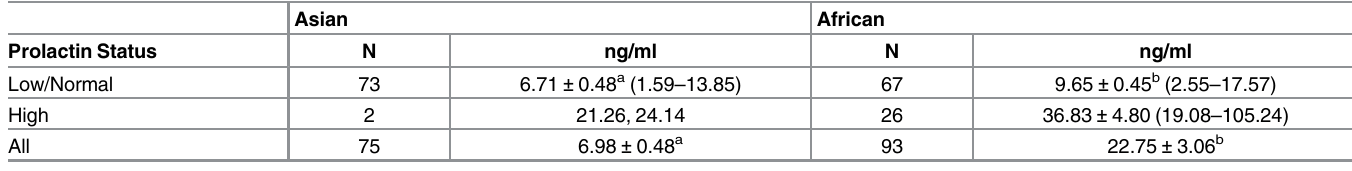
Multi-variable logistic predictive modeling found that the combination of Age and Enrichment Diversity to be most predictive of whether a female elephant would be acyclic, and the Odds Ratios for each significant variable are presented in Table 8. Table 3. Mean ( ± SEM) and mean range of prolactin concentrations in Asian and African elephants with Low/Normal or High prolactin. Calculated cut-offs were < or (cid:1) 14 ng/ml for Asian, and < or (cid:1) 18 ng/ml for African